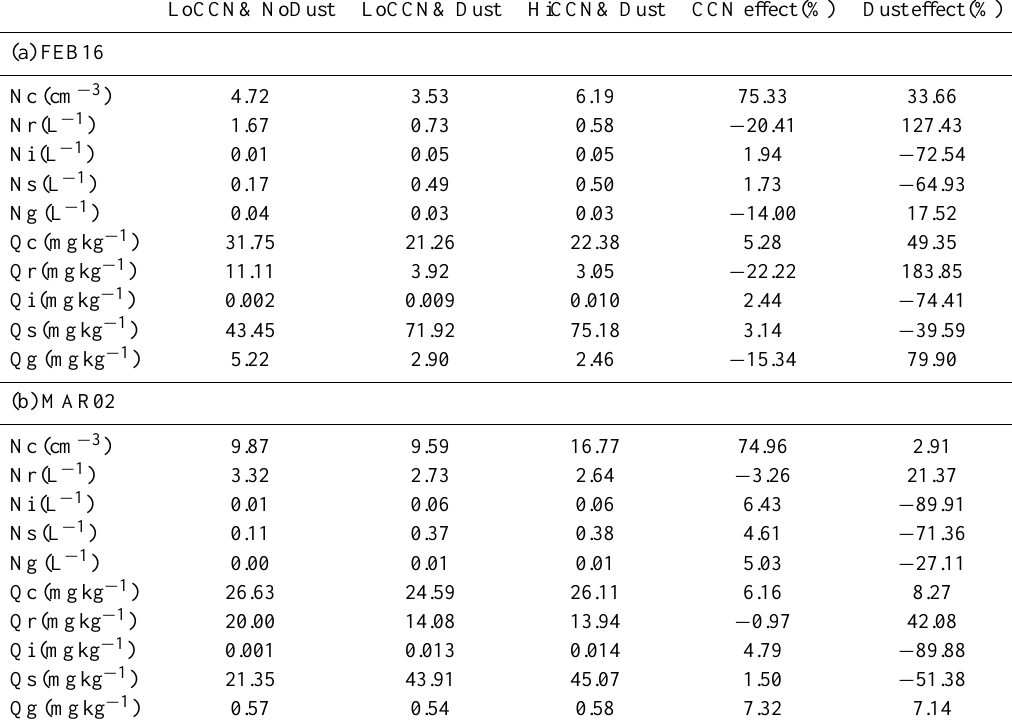
Table 2. Cloud microphysical properties from the simulations of (a) FEB16 and (b) MAR02. Data shown are averaged over all of grid points in domain 2 below 7km during the day (00:00–23:00UTC). The CCN effect is calculated by (HiCCN&Dust-LoCCN&Dust)/LoCCN&Dust · 100, and the dust effect is calculated by (LoCCNNoDust-LoCCN&Dust)/LoCCN&Dust · 100. The symbols in the table are defined as: Nc and Qc denote droplet number concentration and mass mixing ratio, Nr and Qr denote raindrop number concentration and mass mixing ratio, Ni and Qi denote cloud ice number concentration and mass mixing ratio, Ns and Qs denote snow number concentration and mass mixing ratio, and Ng and Qg denote graupel number concentration and mass mixing ratio,